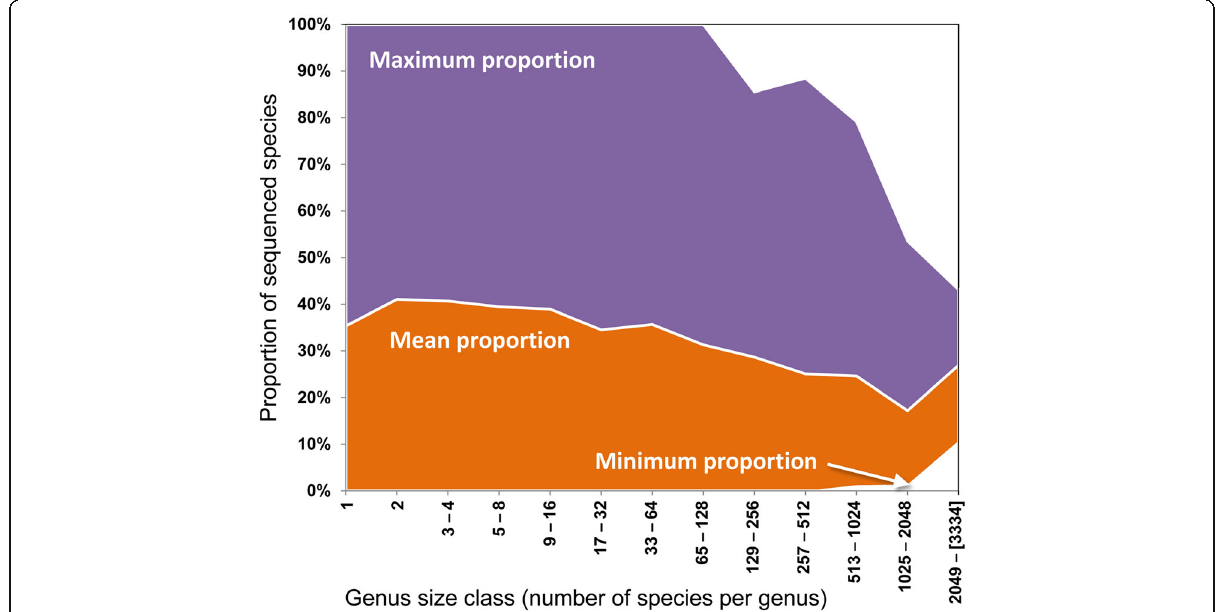
Fig. 4 Proportion of species with sequence data compared to total number of species per genus known in fungal genera, based on integration of the NBCI taxonomy and Species Fungorum . The mean proportion varies between 40% in species-poor genera and as little as 20% in species- rich genera. At least some species-poor to moderately diverse genera have all species sequenced, whereas many others are devoid of sequenced species. In more diverse genera, the maximum proportion of sequenced species sharply drops as a function of species richness, but also the minimum proportion increases, meaning that all large genera have at least some species sequenced but are consistently